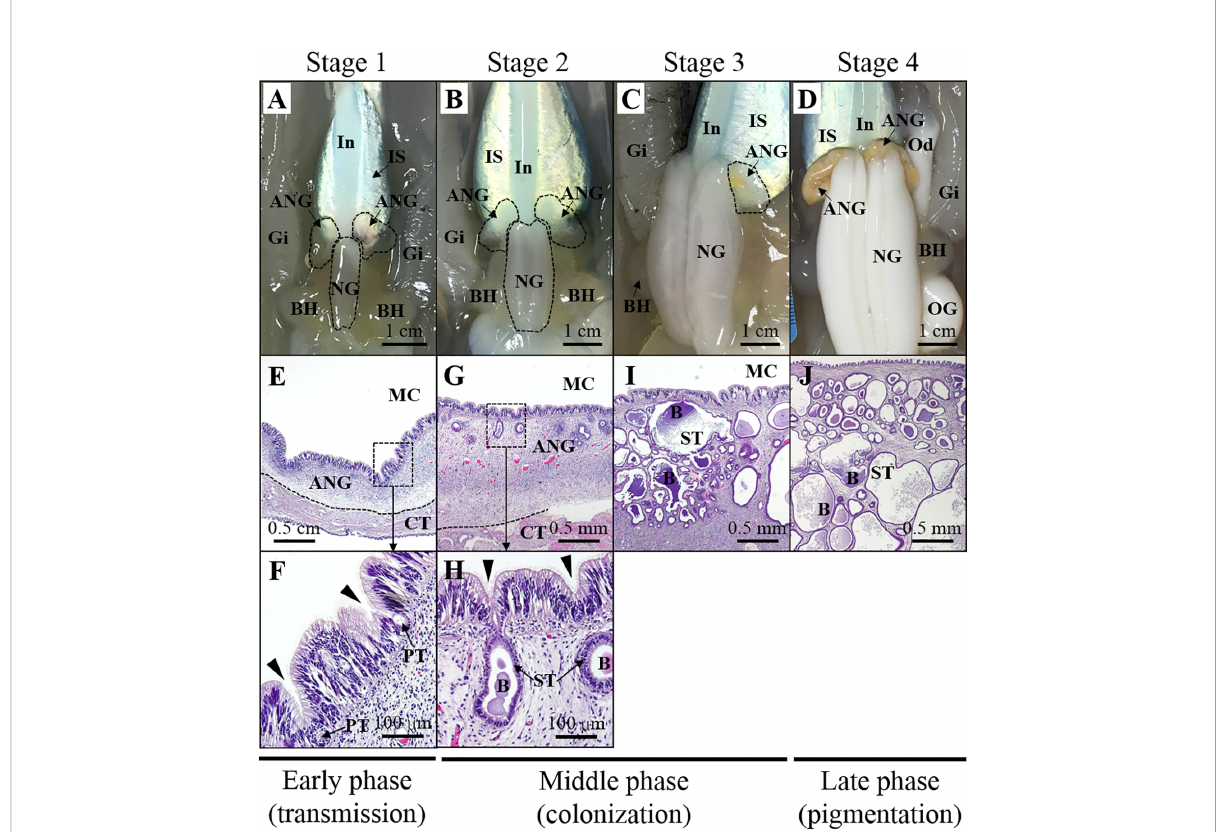
FIGURE 2 Morphological and histological changes during ANG growth. Relationship between morphology (A – D) and histology (E – J) of ANG during female maturation. Morphological changes in ANG stages are shown as follows: (A) juvenile squid with a colorless ANG (stage 1); (B) immature squid with a colorless ANG with several white spots (stage 2); (C) maturing squid with a white/yellow ANG (stage 3); (D) mature squid with a pigmentary ANG (stage 4). Histological changes in ANG stages are shown as follows: (E, F) juvenile squid without visible bacterial colony in the ANG (stage 1); (G, H) immature squid with several bacterial colonies in the ANG (stage 2); (I, J) bacterial colonies widely spread in the ANG (stage 3 and stage 4). Based on the process of ANG development, three phases are divided in this study, namely, early transmission phase, middle colonization phase, and late pigmentation phase. ANG, accessory nidamental gland; B, bacteria; BH, branchial heart; CT, connective tissue; Gi, gills; In, intestine; IS, ink sac; NG, nidamental gland; OG, oviductal gland; PT, primary tubule; ST, secondary